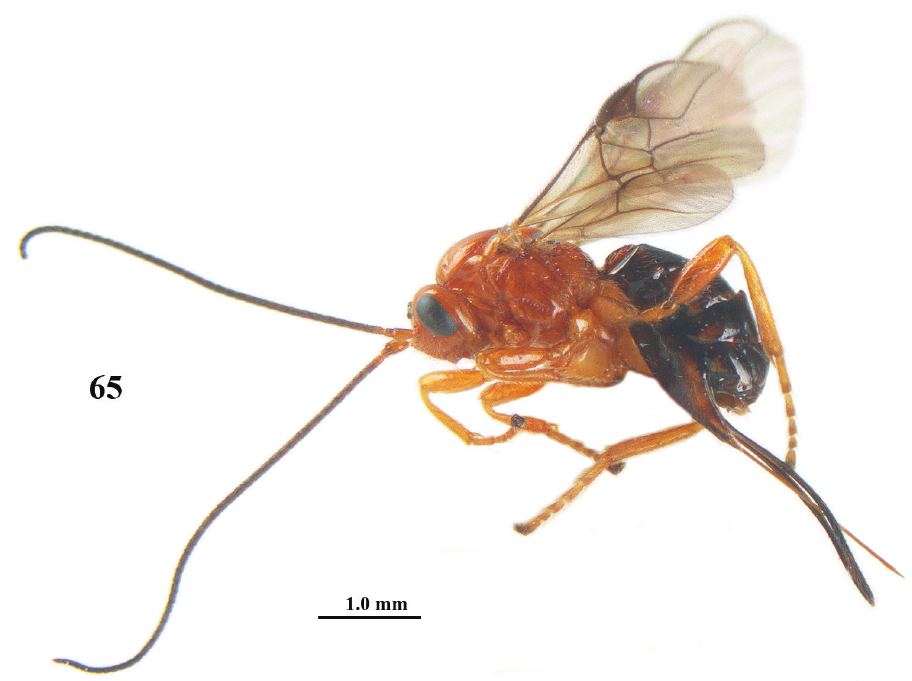
Figure 65. Psyttalia romani (Fahringer), ♀ , Russia, Novorossijka, habitus lateral.